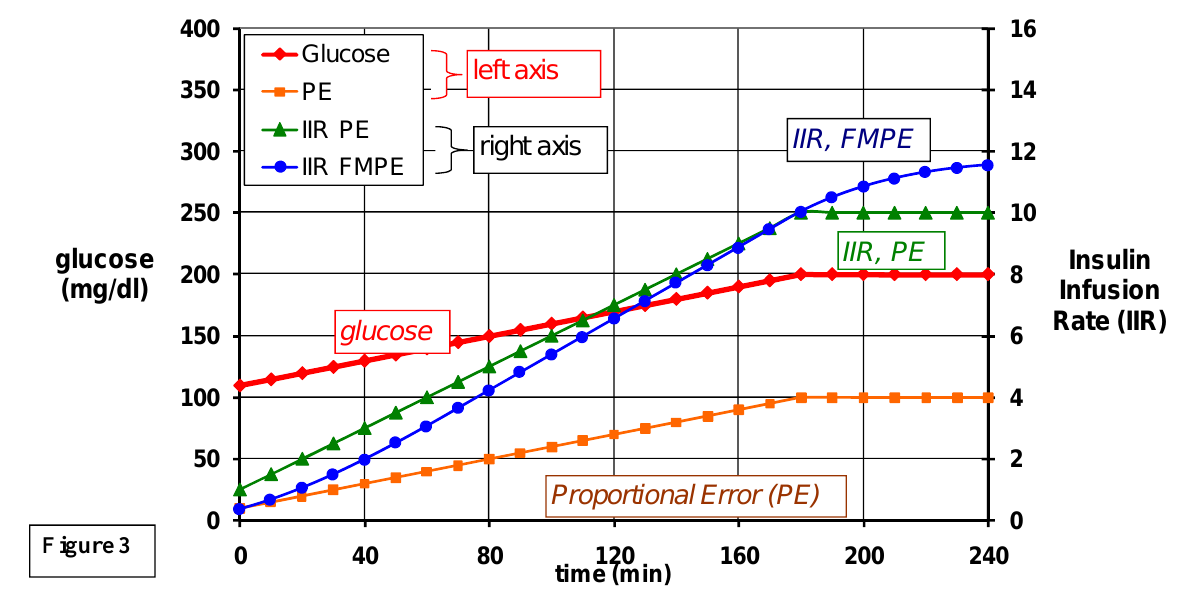
Figure 3. A comparison of insulin infusion rates based only on the proportional error